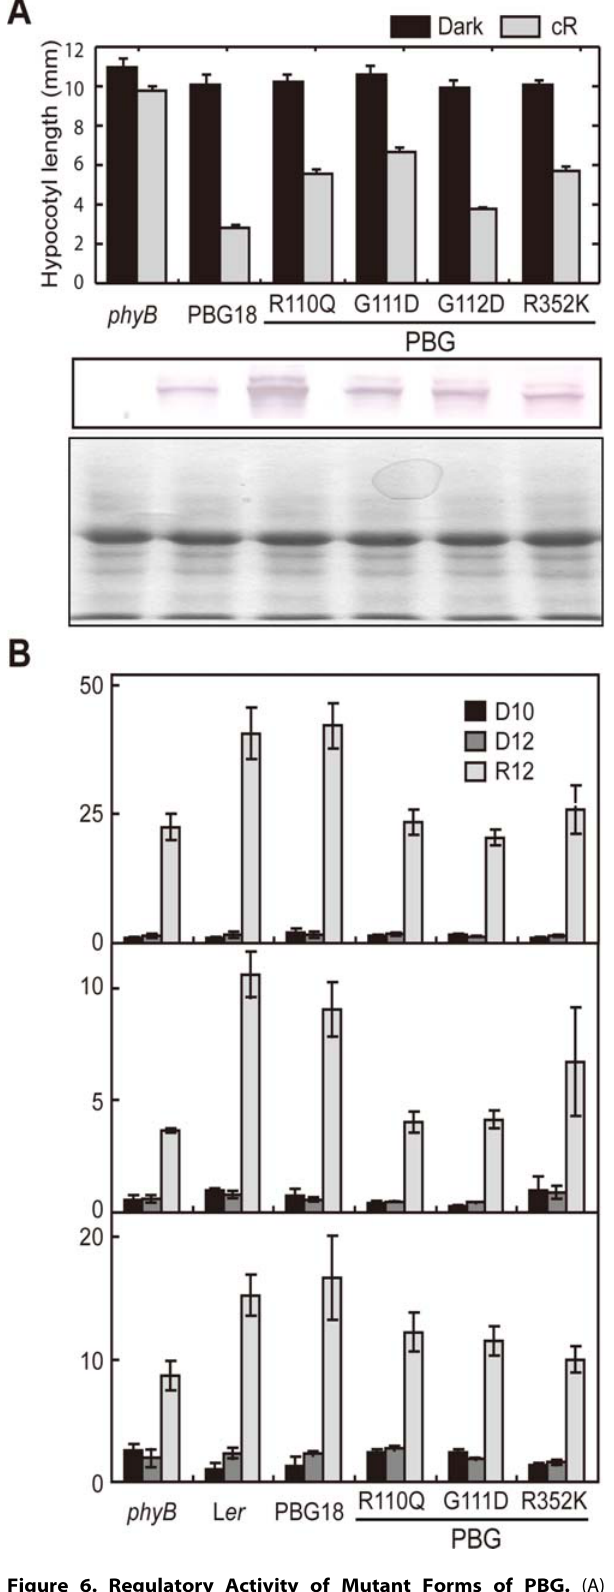
Figure 6. Regulatory Activity of Mutant Forms of PBG. (A) Hypocotyl lengths (upper panel) in transgenic Arabidopsis grown under cR (shaded) or darkness (closed) and immunoblot detection of PBG proteins (lower). For the hypocotyl measurements, plants were